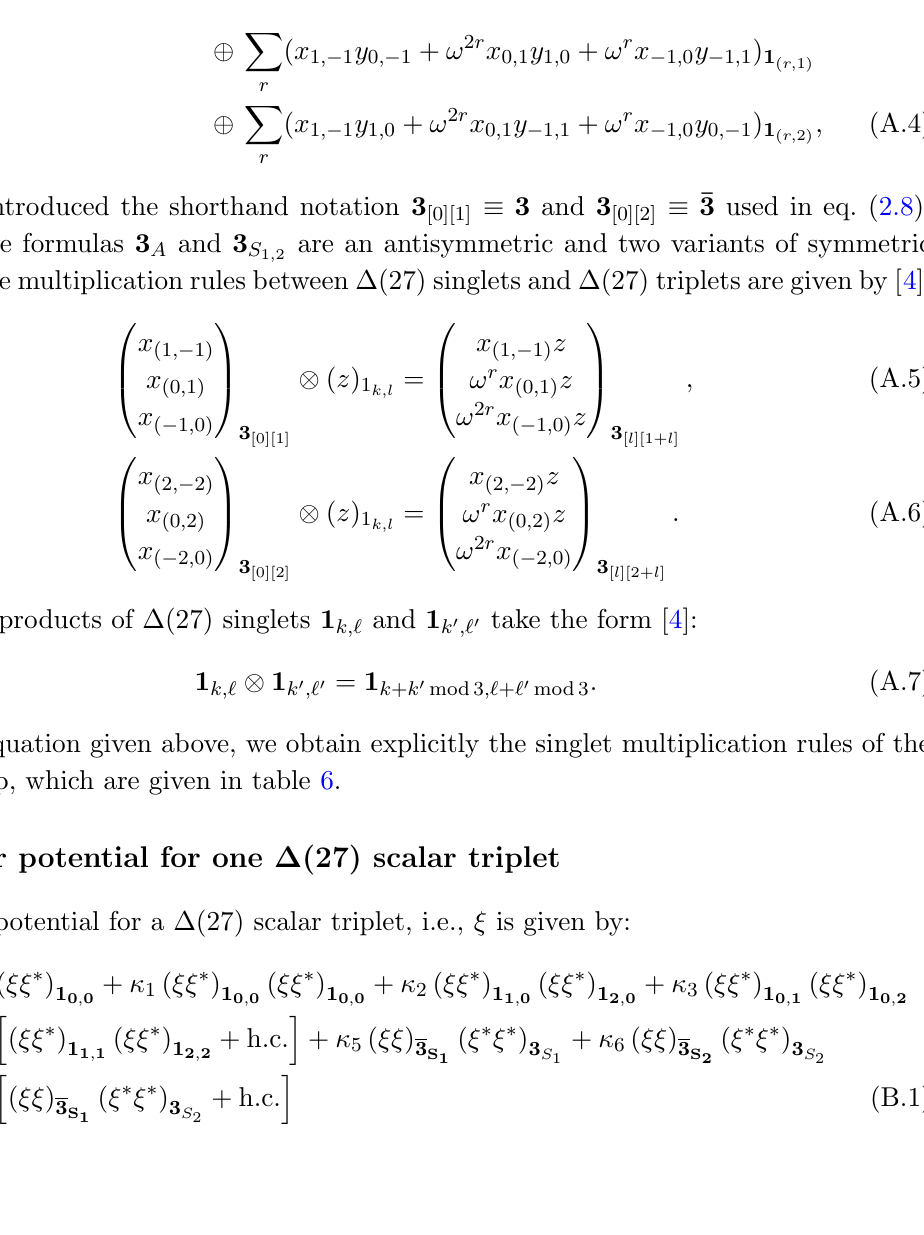
Table 6 . The singlet multiplications of the group